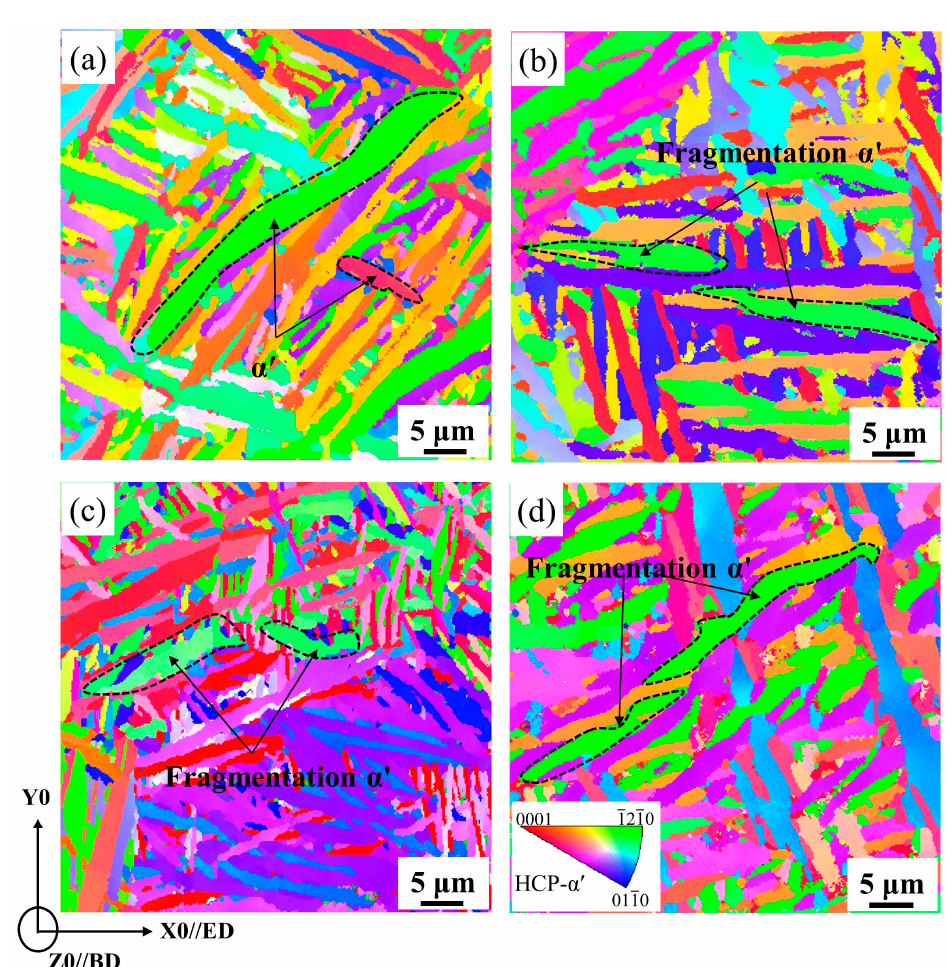
Figure 12. Fragmentation phenomenon of α′ grains in the LPBF-Ti64 samples before and after ECP treatment where the α′ grains are in color according to its crystallographic orientation with respect to the Z0 axis (Z0 inverse pole figure (IPF) micrograph): ( a ) LPBF, ( b ) ECP-1, ( c ) ECP-2 and ( d ) ECP-3.